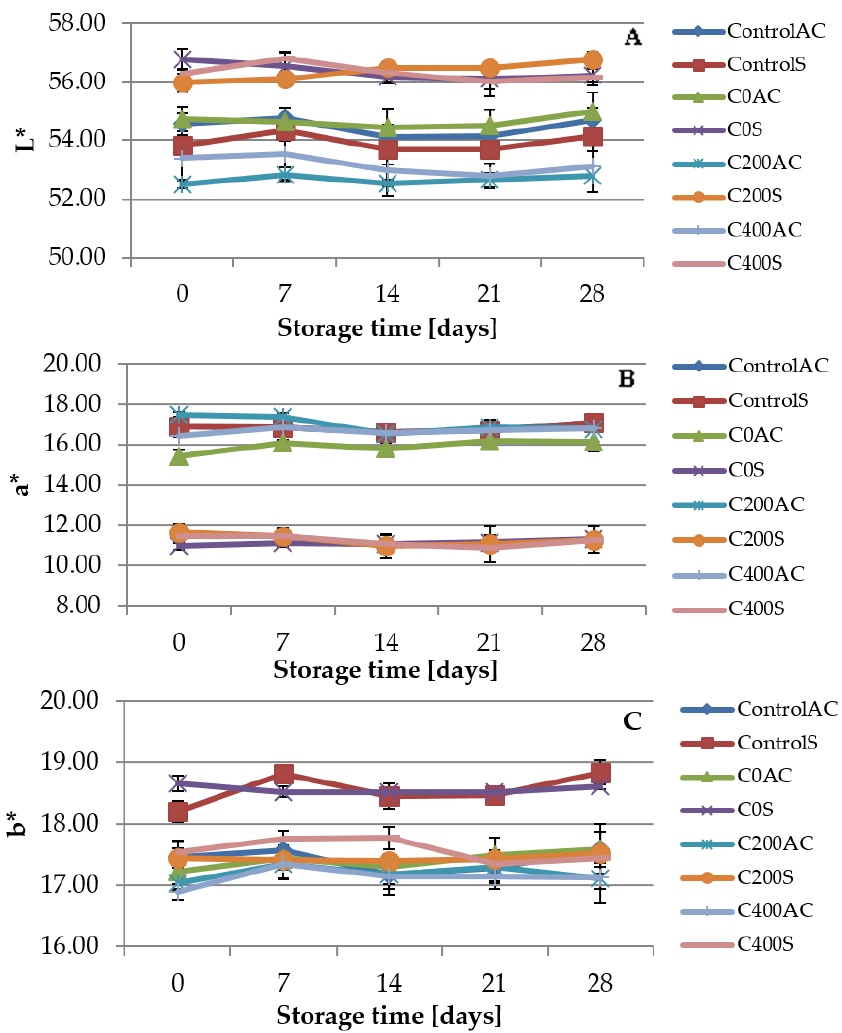
Figure 12. Changes of ( A ) L *; ( B ) a *; ( C ) b * parameters in sausage samples coated with sodium alginate hydrosols.